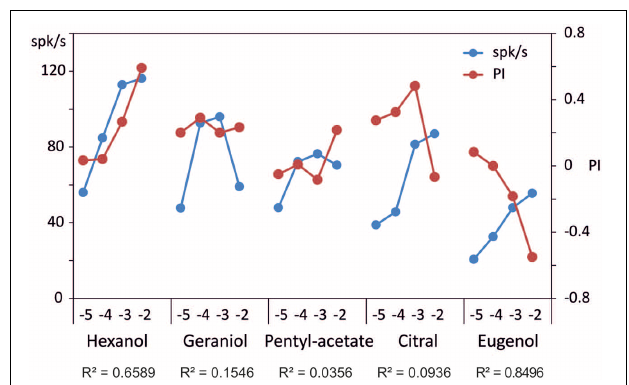
FIGURE 6 | Correlation between the electrophysiological responses and the behavioral responses. On this graph, we plotted the responses to each stimulus as measured on the behavior (PI: red dots) and by recording the spiking activity of B2 sensilla (spk/s: blue dots). A regression was computed between these 2 variables to evaluate if the spiking activity is a good predictor of the behavior (R2 displayed below the molecule name). The concentration of each stimulus is reported on the abscissa by the log 10 value of the molar